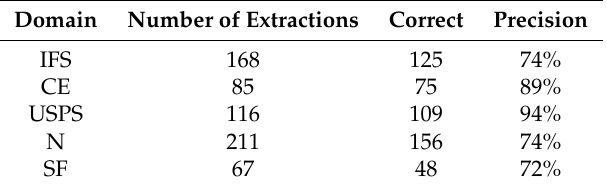
Table 2. Manually-judged precision of field extractions stored in the knowledge graph for each